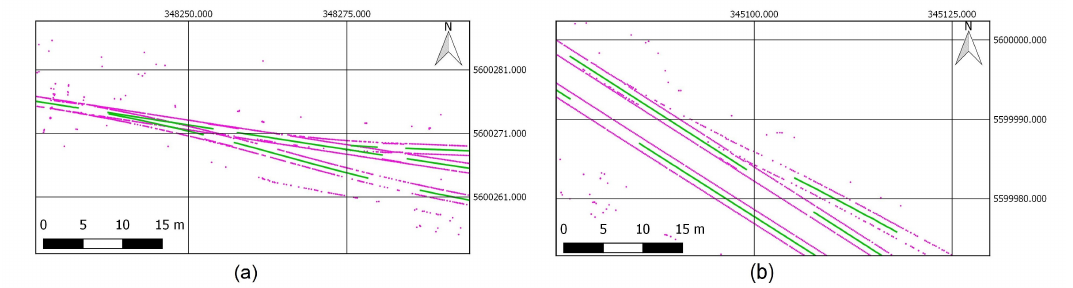
Figure 10. Rail points and center lines identified in two different sections ( a , b ) of the track with a